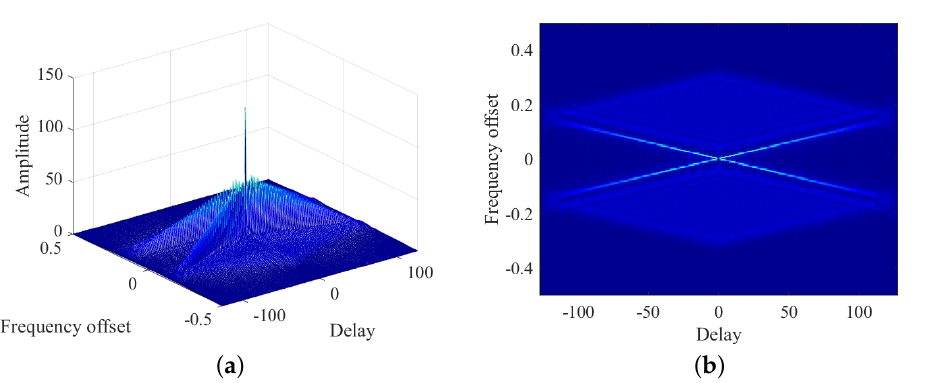
Figure 2. AF of LFM signal. ( a ) Three-dimension map of AF, ( b ) Two-dimension map of